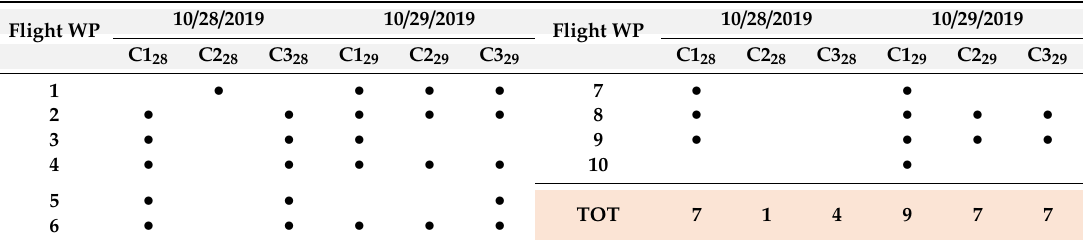
Table 5. For each waypoint and flight over the channels, a dot indicates that at least one velocity vector was computed. Refer to Figure 5 for a planar view of the waypoints. Refer to Table 1 for the initial time of the flight.